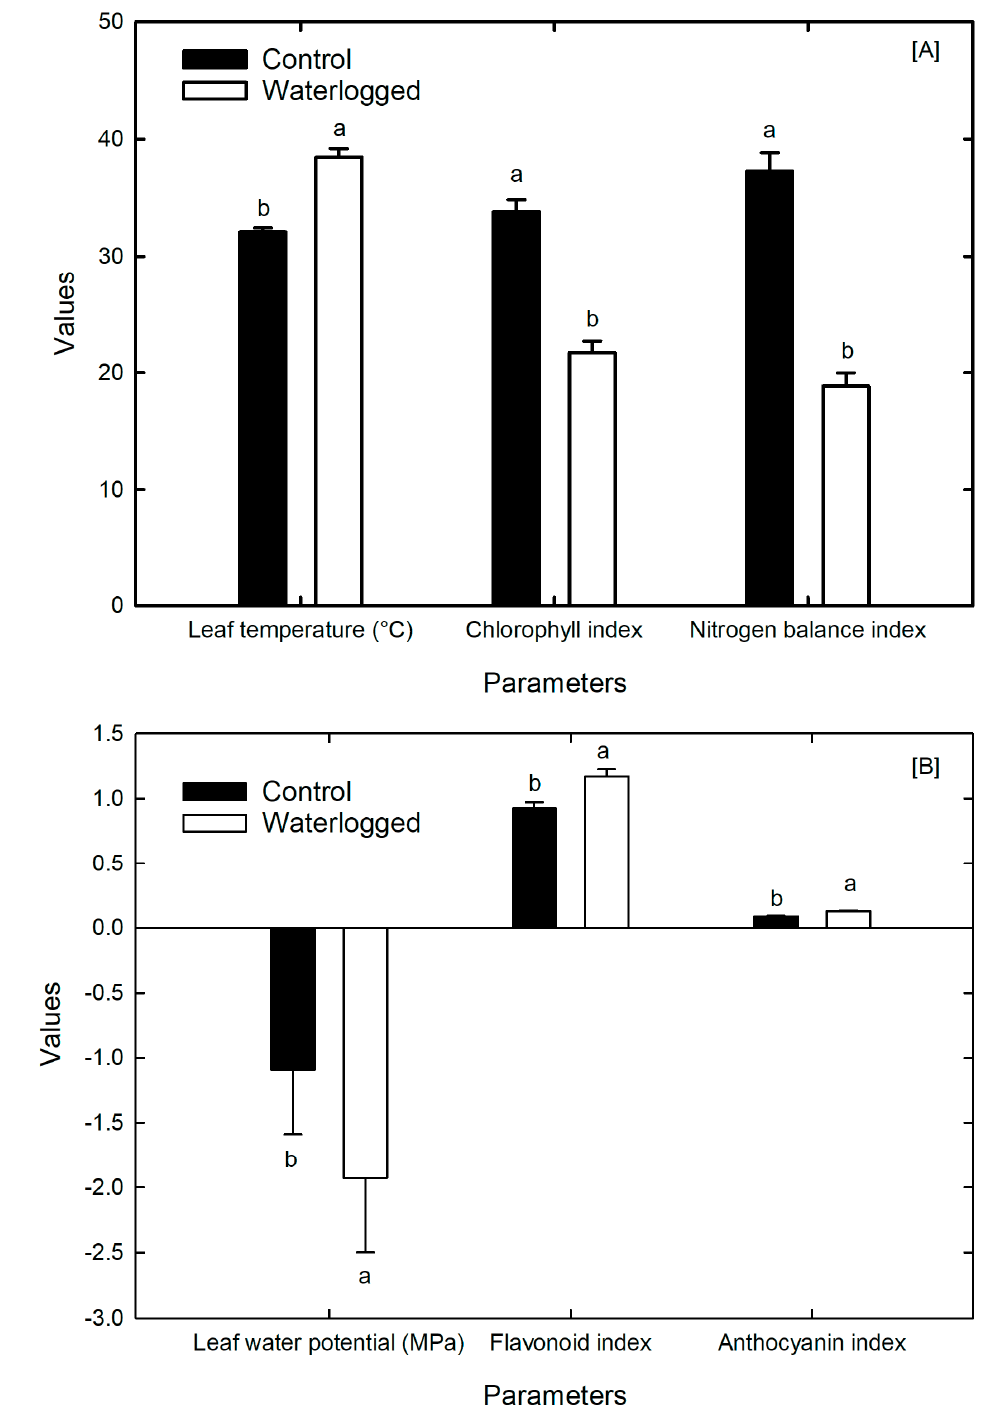
Figure 4. Impact of waterlogging on soybean plants at the reproductive stage: ( A ) leaf temperature ( ◦ C), chlorophyll index, and nitrogen balance index. ( B ) Leaf water potential (MPa), flavanol index, and anthocyanin index in soybean plants at the reproductive stage: canopy temperature of the control and flooded plants during and after waterlogging. The standard error of mean = S.E. ( n = 15). The lowercase letters indicate a significant difference at p < 0.05. Waterlogging also created a nitrogen de fi ciency condition, increasing the fl ooded plants’ fl avanol concentration. The leaf water potential in the control plants was − 1.1 MPa, compared to approximately − 2.0 MPa in the waterlogged plants. Although there was a negligible di ff erence between the anthocyanin index of both control and fl ooded plants (Figure 4B), the fl avanol index in waterlogged soybean plants was approximately 1.3 com- pared to 0.9 in control plants.